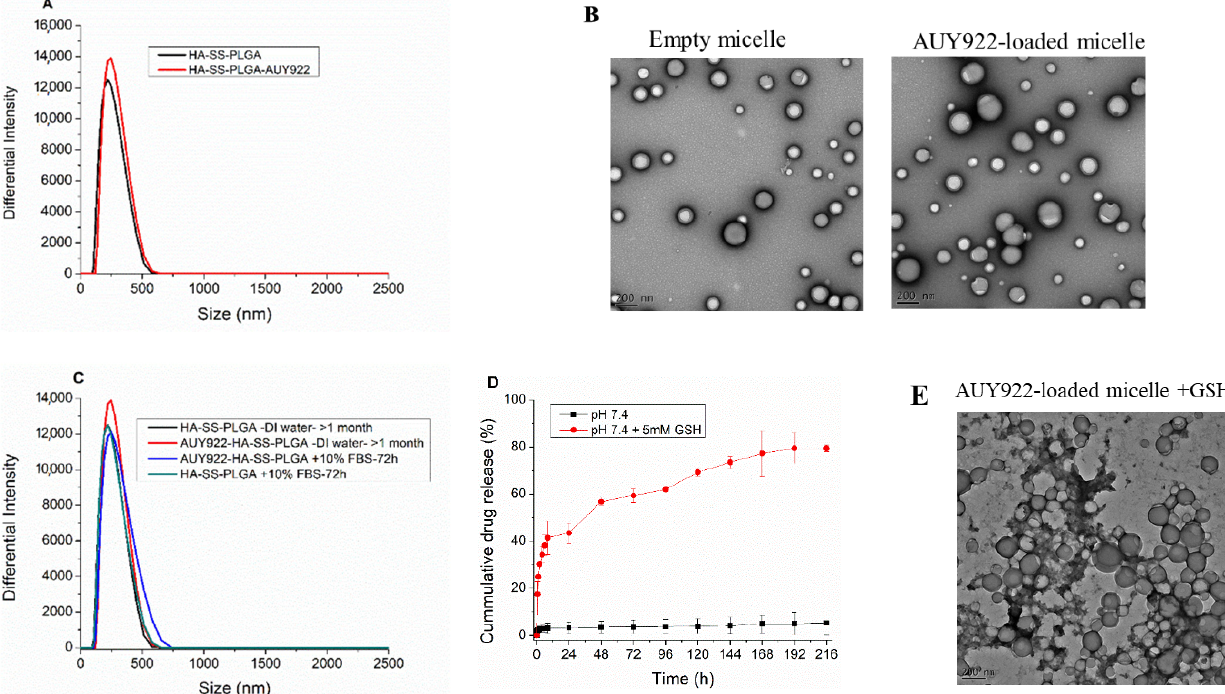
Figure 3. ( A ) Particle size using DLS, ( B ) TEM image of empty micelle and AUY922-loaded micelle, ( C ) Particle size stability in DI water and 10% FBS, ( D ) in vitro drug release in the presence and absence of GSH and ( E ) TEM image of AUY922-loaded micelle in the presence of GSH (5 mM).